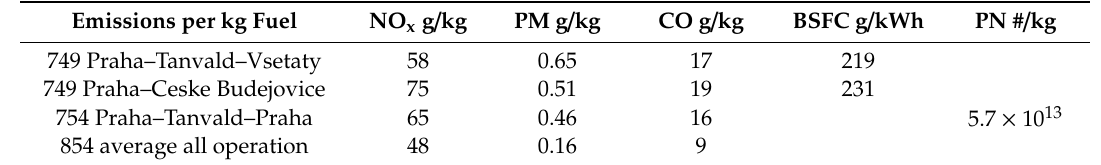
Table 3. Emissions per kg fuel.